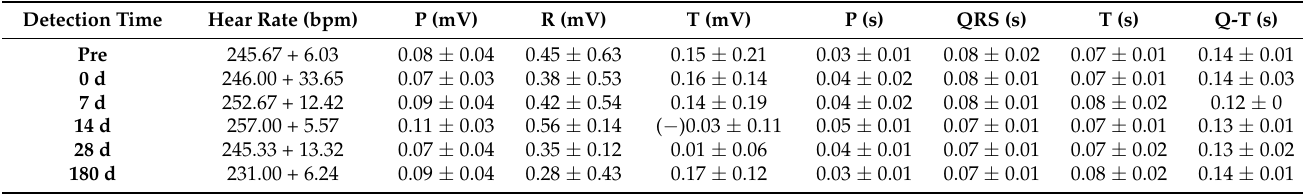
Figure 3. Effects of high level noise on ECG of macaque monkeys. Table 1. Value of the ECG parameters at each time points (M ± SD). Table 1. Value of the ECG parameters at each time points (M ± SD).